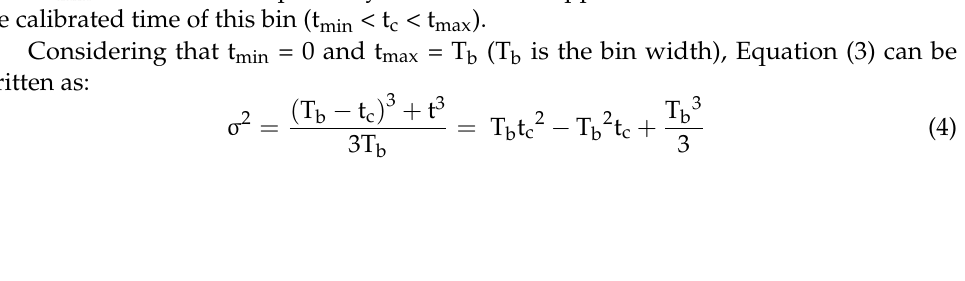
Figure 2. Code density histogram of a simple synchronous TDC with five bins.